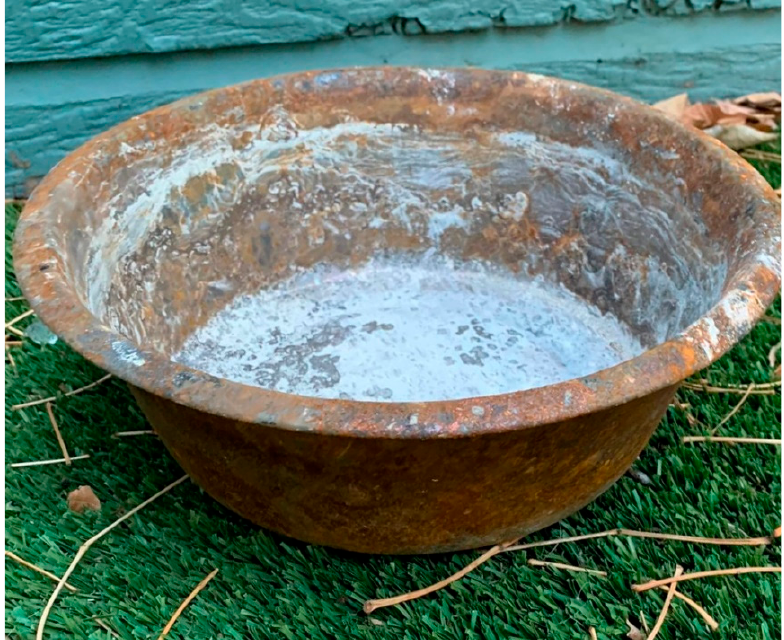
Figure 1. Stainless steel dog bowl scorched in the fire. (Photo credit: Patti Benninghoff-Lawson). In interviews and posts on the “Boulder County Fire Lost and Found Pets” Facebook group, residents who lost pets in the fire held on to hope that their pets escaped the flames and smoke when windows broke in homes. Trained rescuers and volunteers set up traps, trail cams, and feeding stations once they were authorized to enter the area on December 31. This effort was especially concentrated on cats. Soon after the fire, the renowned feline search and rescue expert Shannon Jay arrived to assist with locating missing “fire cats.” Jay had found hundreds of fire cats after California’s 2017 Tubbs Fire and the 2018 Camp Fire. Working with drone pilots, Jay had also rescued cats lost in the deadly 2021 Kentucky tornado. Jay brought an aerial thermal imaging device and a ground-level